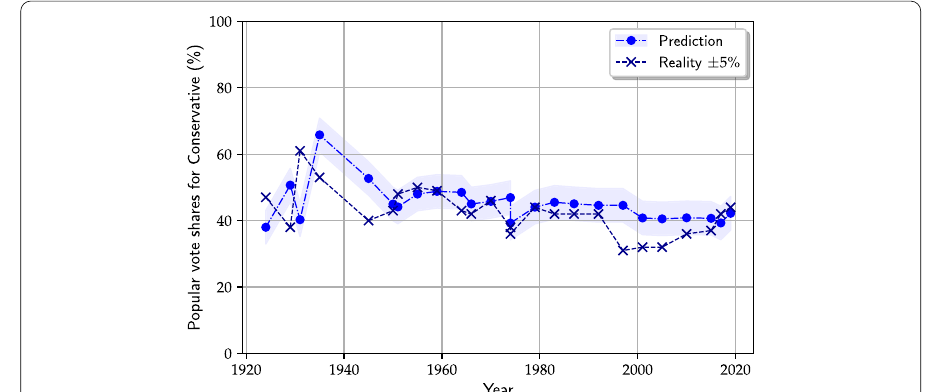
Fig. 1 Percentage of popular votes for Conservatives in the UK, prediction and reality. The shaded area covers a ± 5% deviation away from the predictions